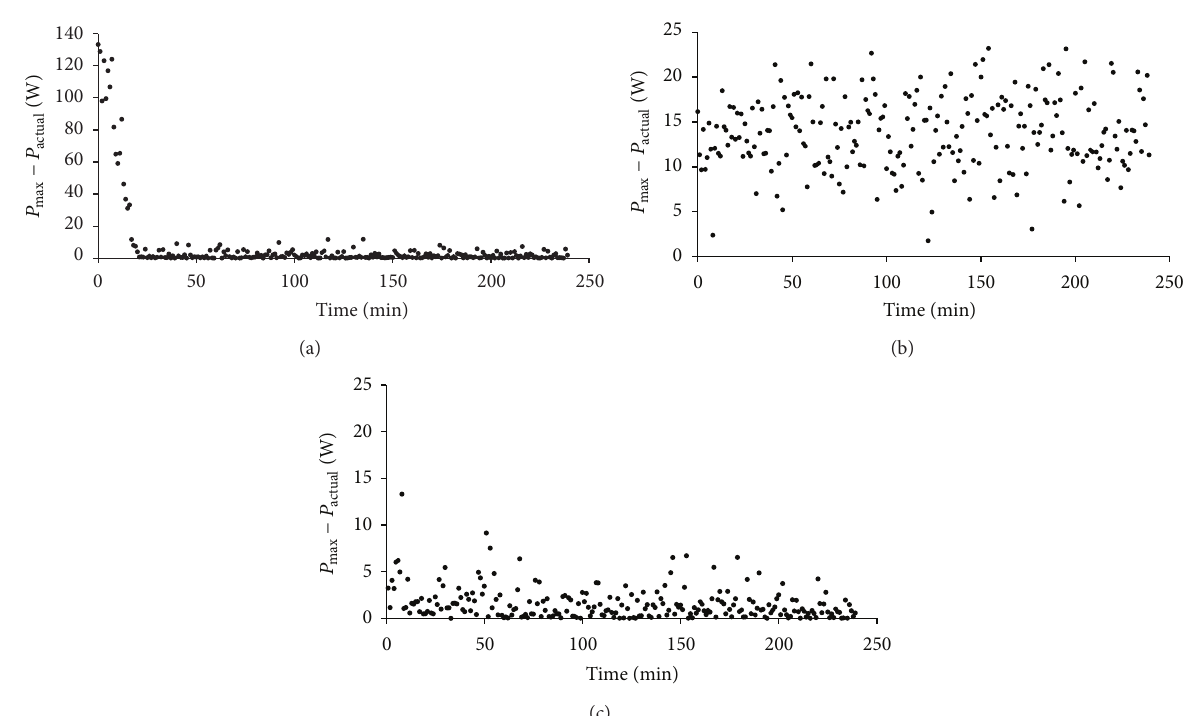
Figure 8: The maximum power point minus the predicted current power point corresponds to the same sensing time: (a) P&O method, (b) open-circuit voltage method, and (c) RLMPPT method.